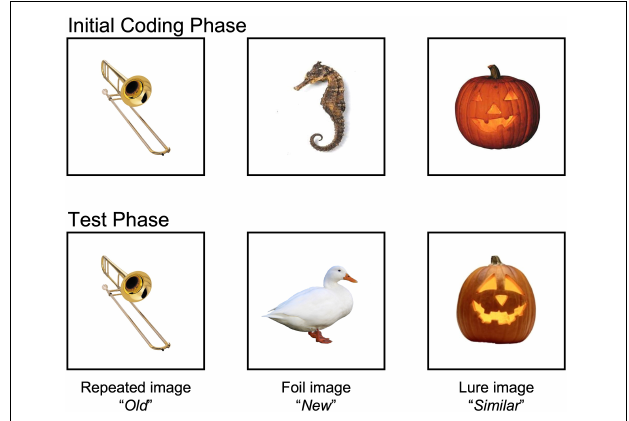
FIGURE 1 | Mnemonic Similarities Task (MST). The MST measures hippocampal dependent memory by having participants discriminate between highly similar, but different memory. During the initial coding phase, participants were presented with 60 images that they had to identify as “indoor” or “outdoor” objects. During the test phase, participants were presented with 192 additional images. A total of 64 images were exact repetitions (images presented during the initial coding phase; correct response = “Old”), 64 novel foils (new images they had not been seen before; correct response = “New”), and 64 images were similar lures (images that were similar to a previously shown image, but not exactly identical; correct response = “similar”). High-interference memory was calculated by subtracting the proportion of lures that were correctly identified as “Similar” from the proportion of foils that were mistakenly identified as “Similar” [p(“Similar”| Lure) – p(“Similar”| Foil)]. This corrects for any overall bias of responding “Similar” to stimuli. General recognition memory was determined by whether participants correctly identified repeated stimuli as “Old” from the proportion of foils that were mistakenly identified as “Old” [p(“Old”| Repeat) – p(“Old”| Foil)]. Images available at: https://faculty.sites.uci.edu/starklab/mnemonic-similarity-